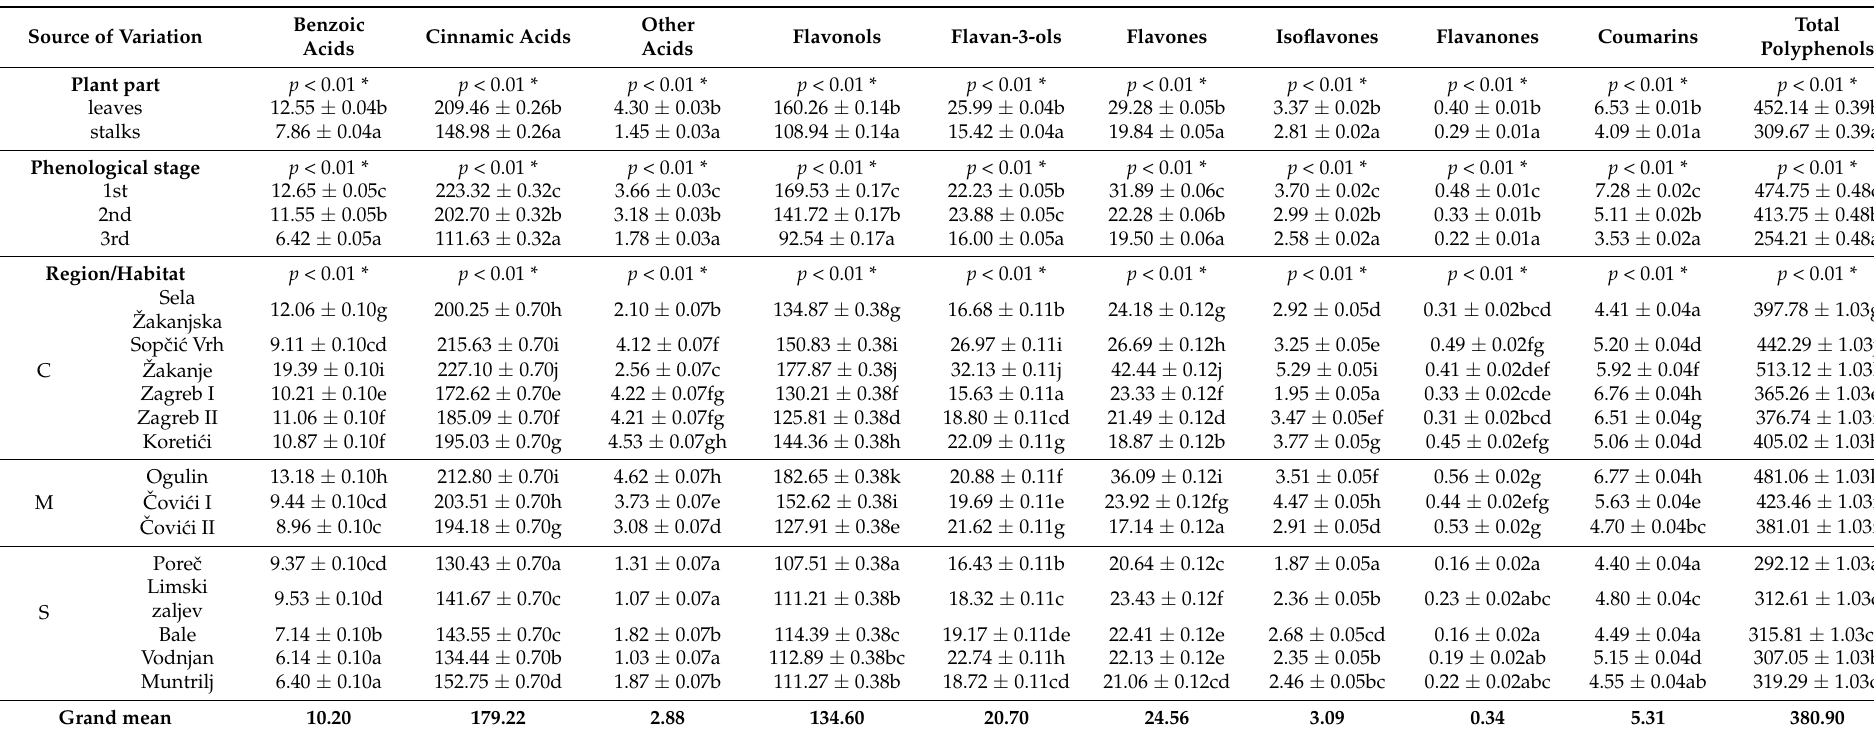
Table 3. The differences in polyphenols content (mg 100 g − 1 dm) in wild nettle ( Urtica dioica L.) due to the plant part, phenological stage and